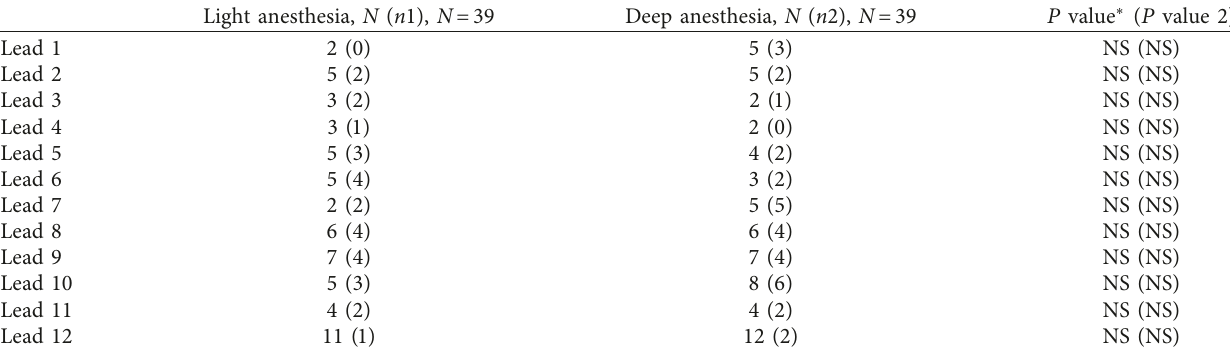
Table 2: Number of nonrecordable leads within light and deep